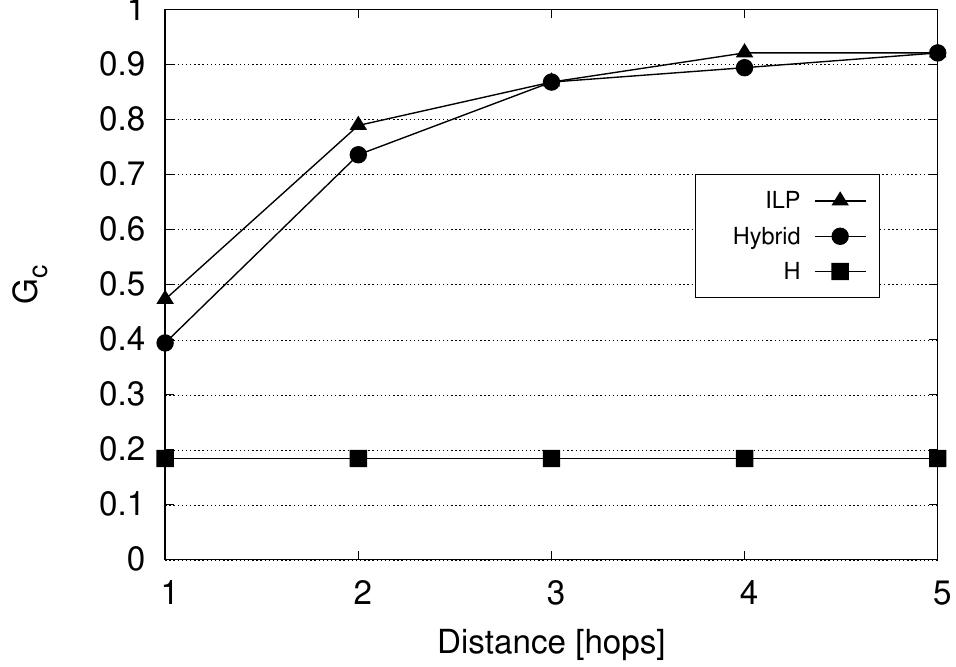
Figure 6. Centralization gain as a function of the allowed distance between RRUs and edge nodes for network N 38 : Results are reported for the maximum cost for hybrid (phase 1 and phase 2), and